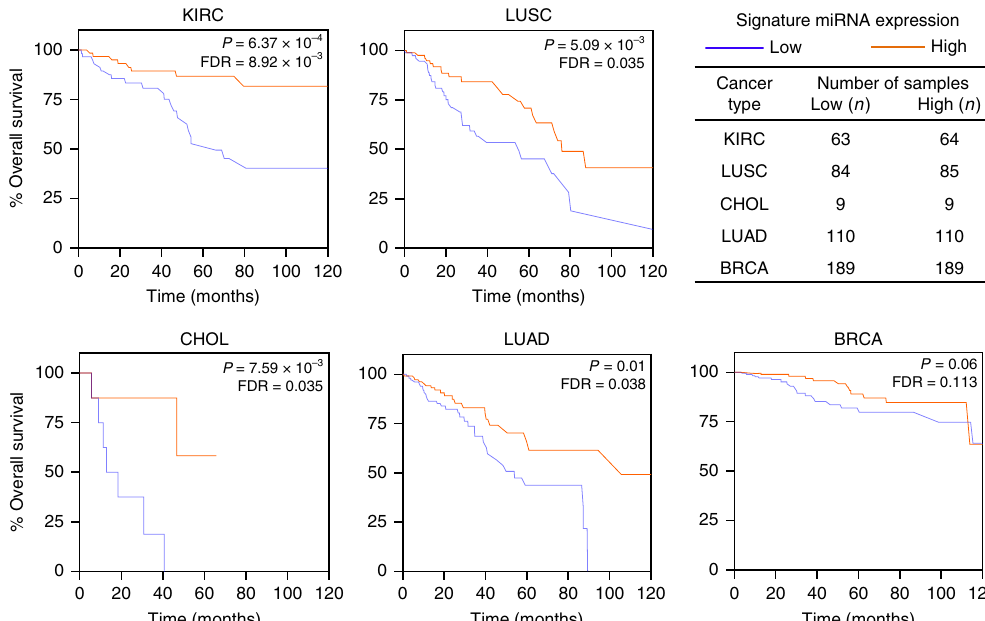
Fig. 7 A four-miRNA expression signature correlates with patient overall survival across diverse cancer types. Kaplan – Meier plots of overall survival according to a survival predictor based on the average expression of miR-145-5p, miR-145-3p, miR-30a-5p, and miR-30a-3p. For each cancer type, patient samples were ranked according to the average expression of the four miRNA and divided into four quartiles. Lowest (blue lines) and highest (orange lines) quartile groups were used for Kaplan – Meier survival analyses; statistical signi fi cance was measured using log-rank test. False-discovery rate (FDR) values were of miR-145-5p, miR-145-3p, miR-30a-5p, and miR-30a-3p for